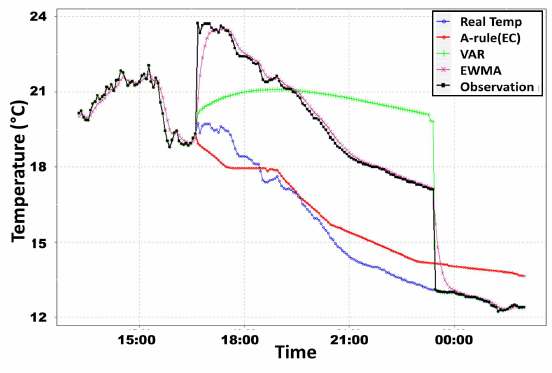
Figure 12. Detection and correction of faulty data from temperature sensor, when A-rule(EC) does not perform